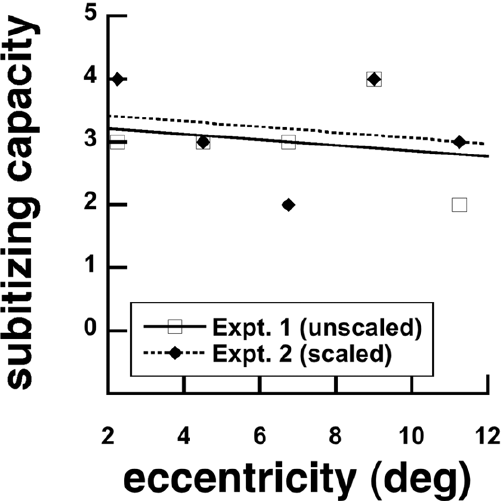
Figure 3. Subitizing capacities as a function of viewing eccentricity were generally flat for unscaled (Experiment 1) and scaled (Experiment 2) stimulus sizes.